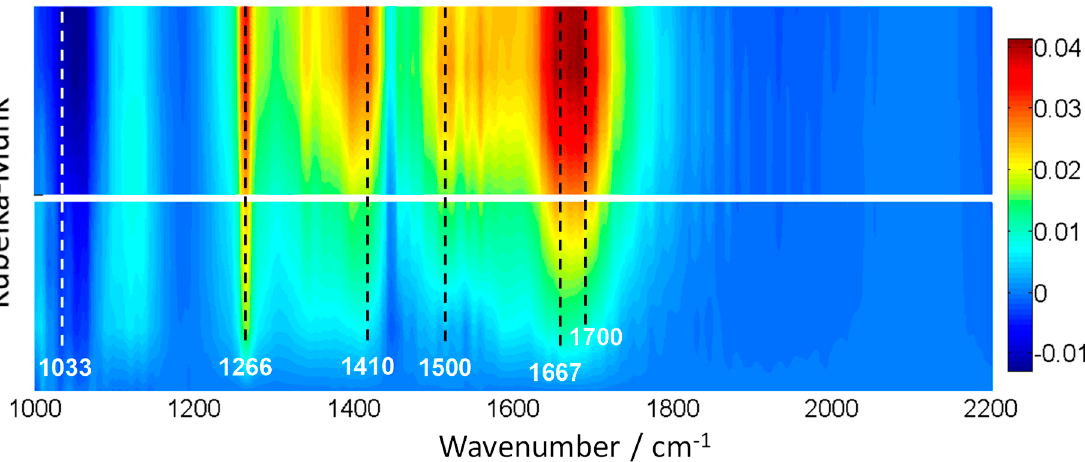
Figure 9. Difference infrared spectra of the T-S sample using an ethylene glycol/water mixture under dark ( bottom panel ) and illumination ( upper panel ).